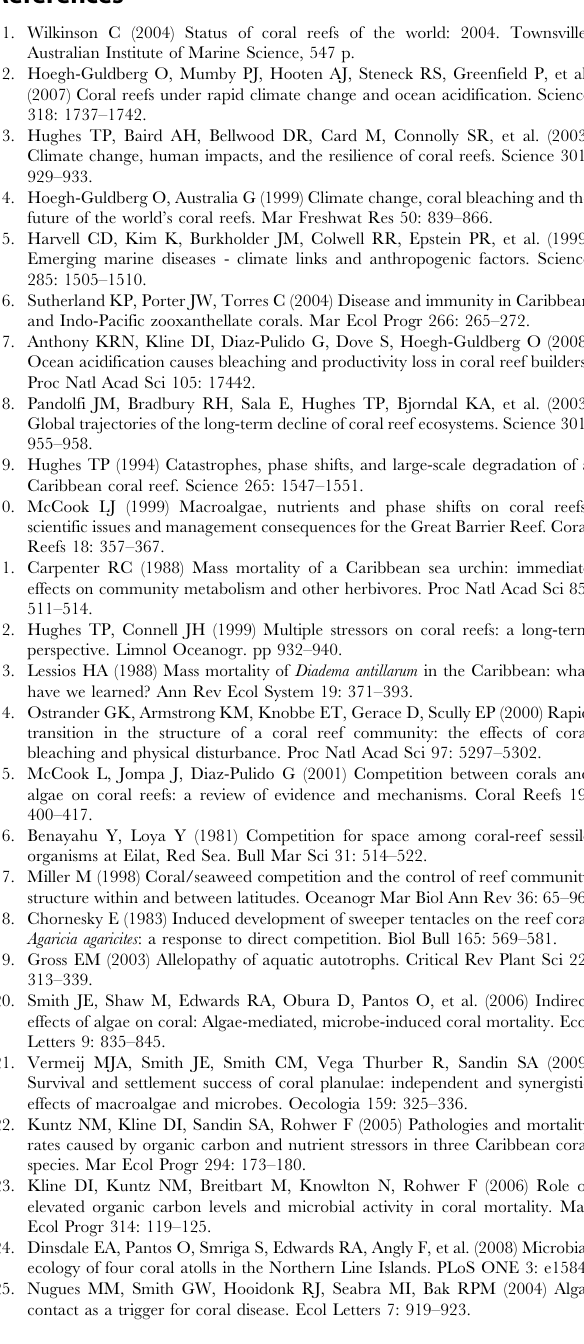
Figure S2 Two types of interaction zones between corals. A) Active coral interaction zone where one coral is attacking another and damaging the tissue with mesenterial filaments. B) Interaction zone between two corals where algae has established itself between the two competing